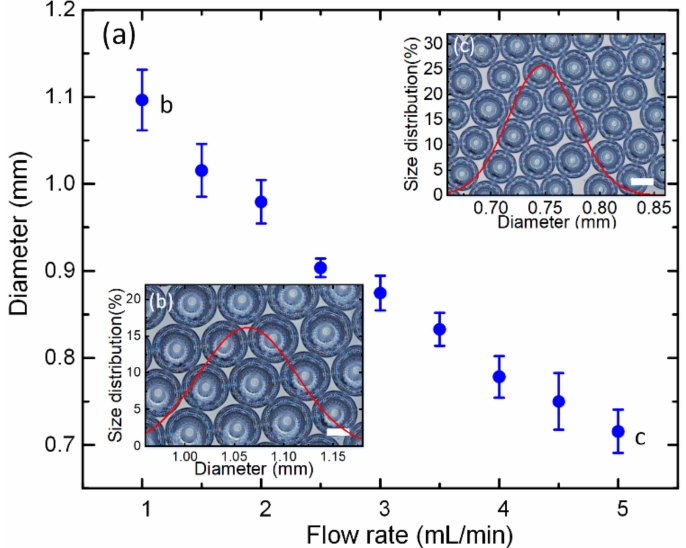
Figure 2. ( a ) The diameter of microbubbles generated in the SPFM device (collection tube, I.D. = 900 µ m) can be tuned by adjusting the flow rate of the water phase; ( b ) large bubbles with good monodispersity were generated at a relatively small flow rate, 1 mL/min; scale bar is 500 µ m; ( c ) small microbubbles generated in a relatively large flow rate, 5 mL/min, have a narrow size distribution. The scale bar is 500 µ